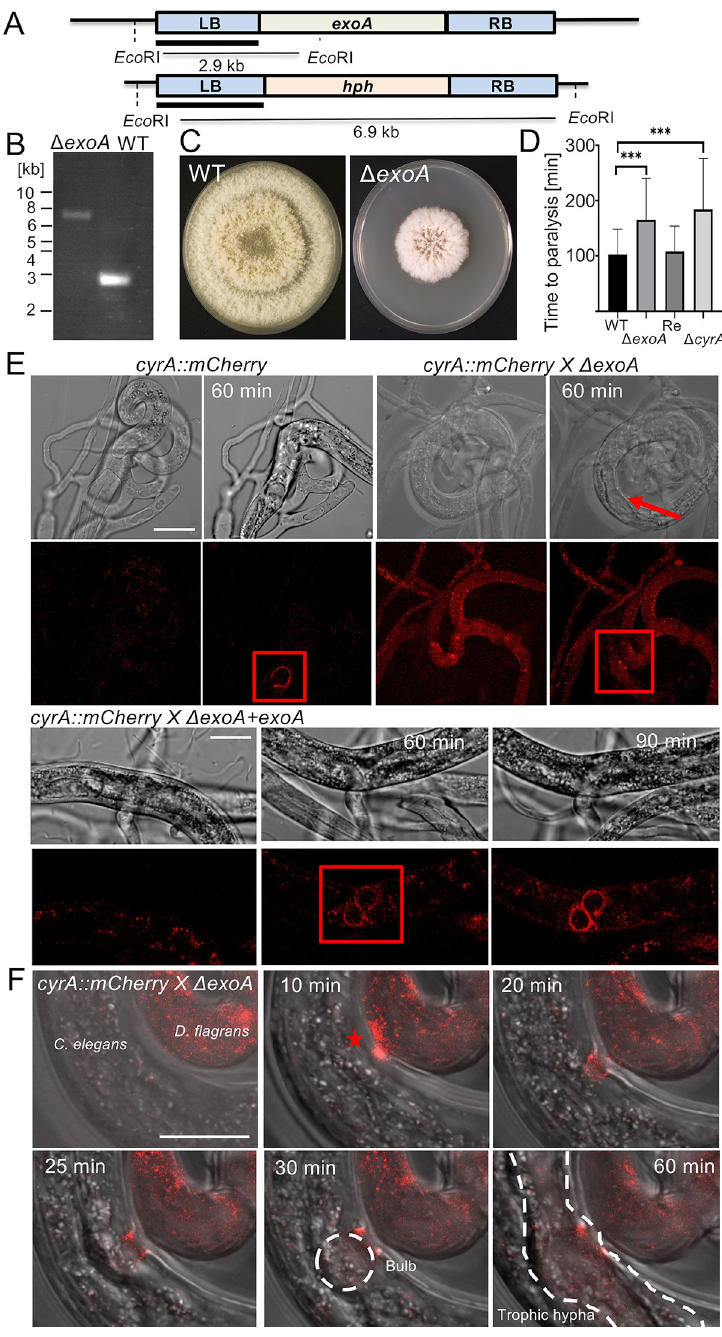
Fig 5. The exocyst component exoA is necessary for CyrA accumulation at the infection bulb. (A) Scheme of the deletion strategy for exoA . The gene was deleted via homologous recombination by flanking the hygromycin resistance cassette (hph) with 1 kb upstream (LB) and downstream (RB) flanks of exoA . The LB was used as a probe. (B) Southern-blot of genomic DNA of the Δ exoA -deletion mutant (strain sNH60) and WT using the probe indicated in (A) . (C) D . flagrans wildtype and the Δ exoA- deletion strain were grown for 7 days at 28˚C on PDA. (D) Virulence assay with the D . flagrans wildtype (WT), the Δ exoA -deletion mutant, the complementation strain (Re) and the Δ cyrA - deletion mutant. The strains were co-incubated with a mixed C . elgans N2 population on thin LNA-slides for 24 h at 28˚C. After trap formation the N2 worms were washed off the slides and a synchronized population of Ban126 L4-larvae was added to the traps just before the microscopical observation. Pictures of single traps were taken every 5 minutes for 20 hours. The time from the capturing event to full paralysis of the nematodes was taken. The statistical